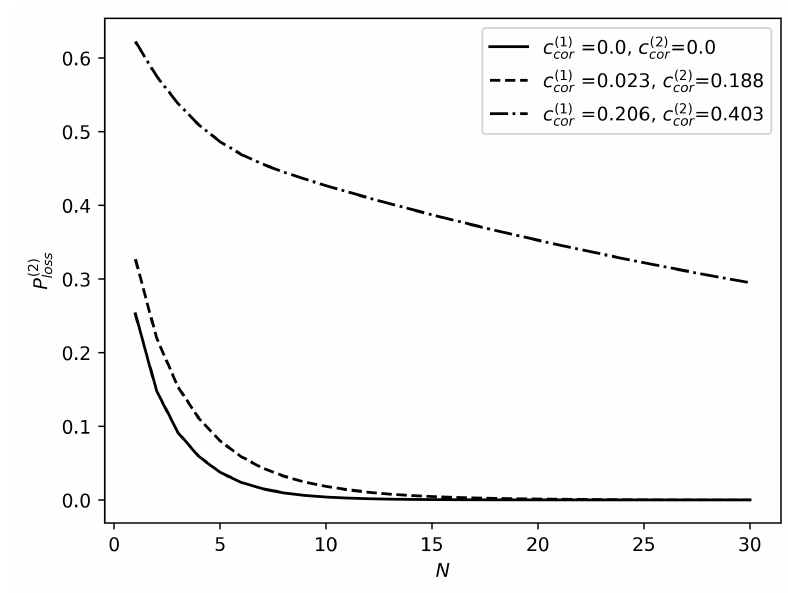
( 2 ) as a function of the buffer capacity N for BMMAP s with different loss